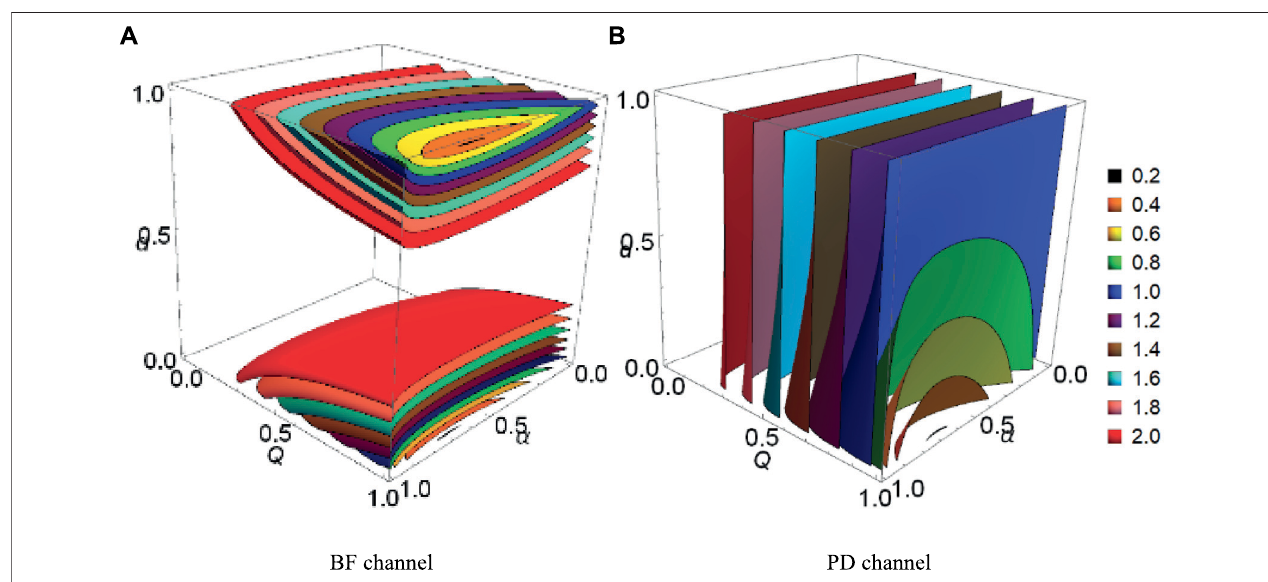
FIGURE6| (Coloronline)3DcontourplotofGMSinequalityversusthestateparameters Q and α andthechannel-noisefactor d underthedifferentnoisychannels. (A) BF channel. (B) PD channel.